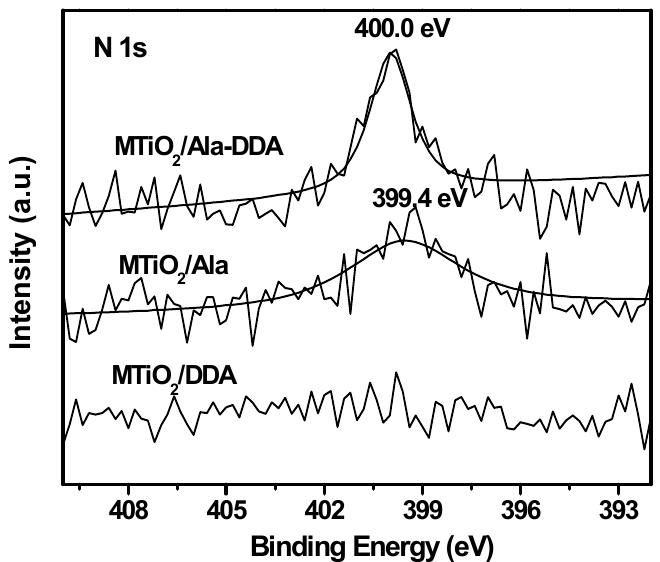
Figure 6. X-ray photoelectron spectroscopy (XPS) N 1s spectra of MTiO 2 / Ala-DDA, MTiO 2 / Ala, and MTiO 2 / DDA.